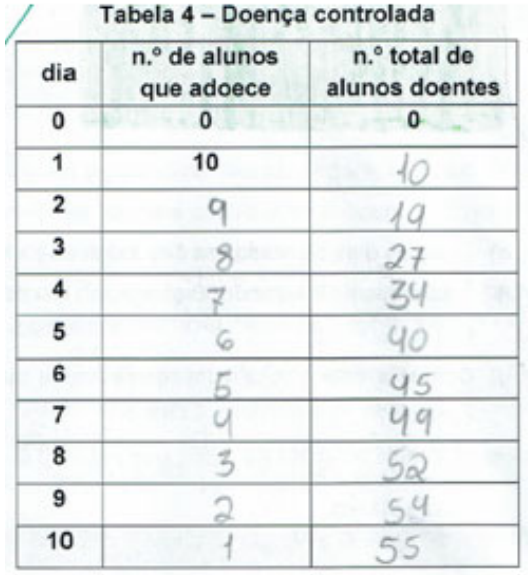
Figure 5. Probability to infect someone is less than one.